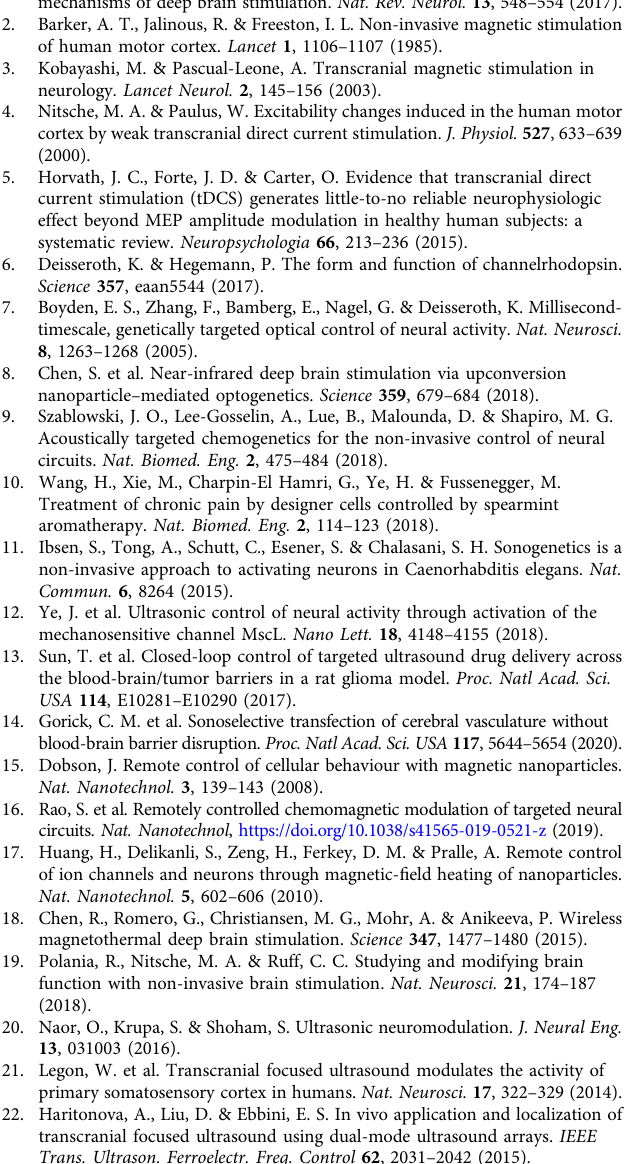
Quantify ultrasound-induced shank vibration on neuronexus electrodes . A COM- SOL model was created to simulate electrode de fl ection properties while